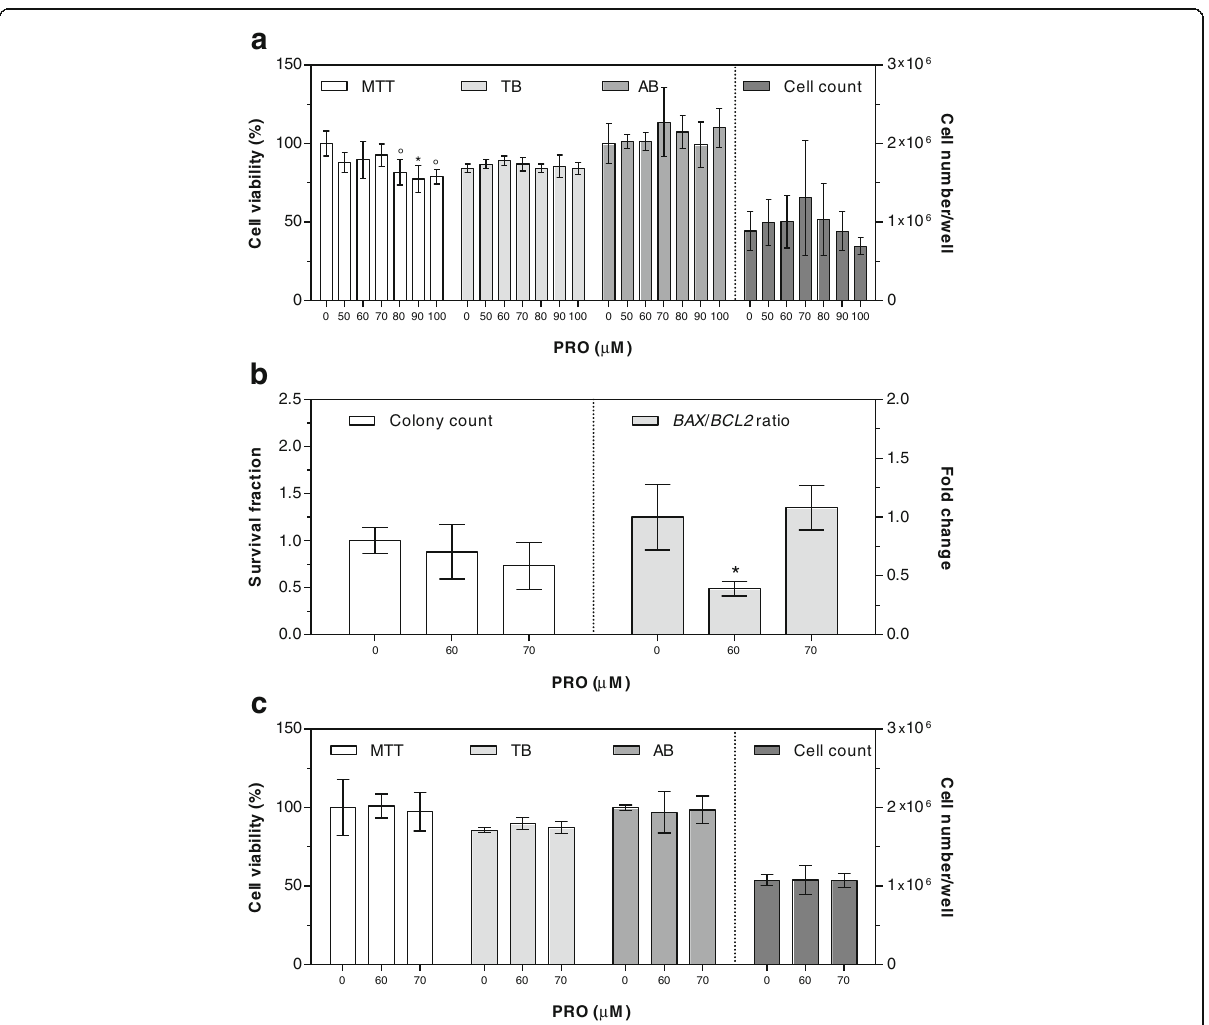
Fig. 2 Cytotoxic effects of PRO after 24 ( a , b ) and 48 ( c ) hours of supplementation. Cell viability by MTT and AB is expressed as percentage of control cells (assigned as 100%). TB is expressed as percentage of total cells. Cell count is expressed as number of cells per well. Colony count by clonogenic assay is expressed as survival fraction. BAX/BCL2 gene expression ratio is expressed as the mean fold change of relative expression compared to control cells, normalized to one. Data are means ± SD of six samples obtained from two independent experiments. Statistical analysis was by the one-way ANOVA (panel a : MTT p < 0.001, TB, AB, and cell count n.s.; panel b : colony count n.s., BAX/BCL2 ratio p < 0.001; panel c : MTT, TB, AB, and cell count n.s.) using Dunnett ’ s as post-test to compare supplemented cells to control ones (° p < 0.01; * p <